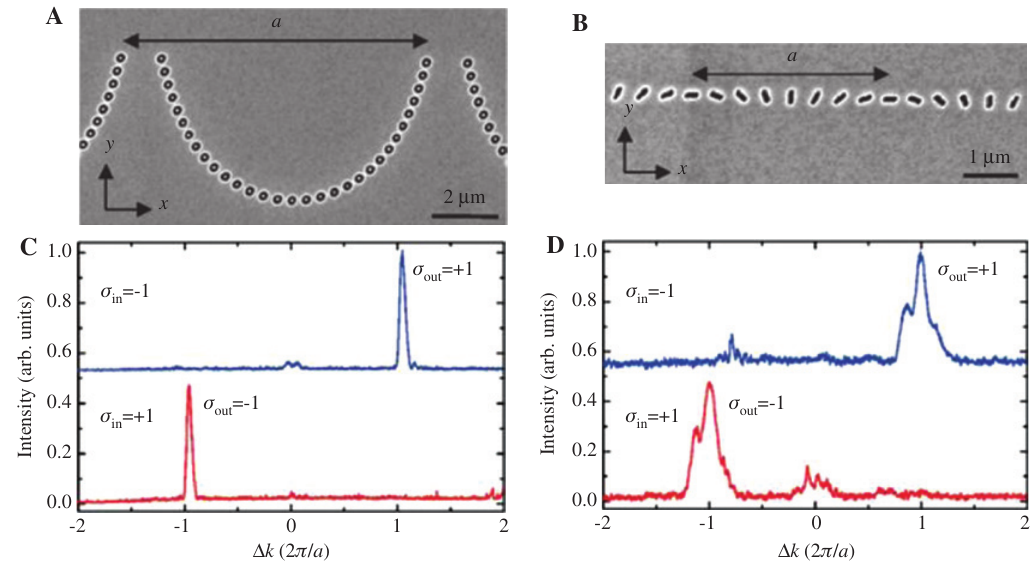
Figure 11: SEM images of a plasmonic chain with identical unit cells but arranged in a curve with period a (A) and another chain with rotated rectangular cells in a straight line (B). (C) and (D) are the spin-dependent momentum deviations for these two different arranged plasmonic chains, respectively. The red and blue lines stand for incident spin states σ = + 1, respectively. Adapted from Ref.